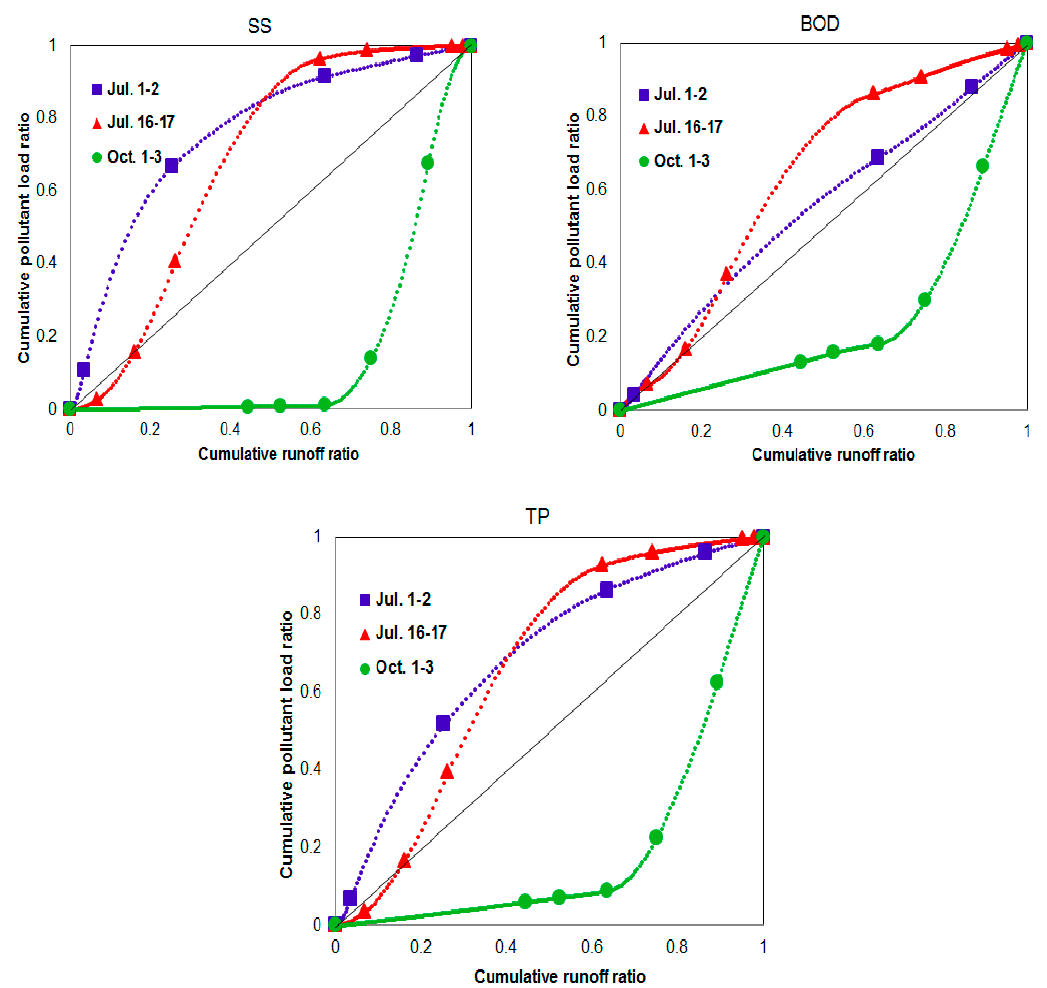
Figure 6. M(V) curve for Jungjohangcheon. Figure 6. M ( V ) curve for